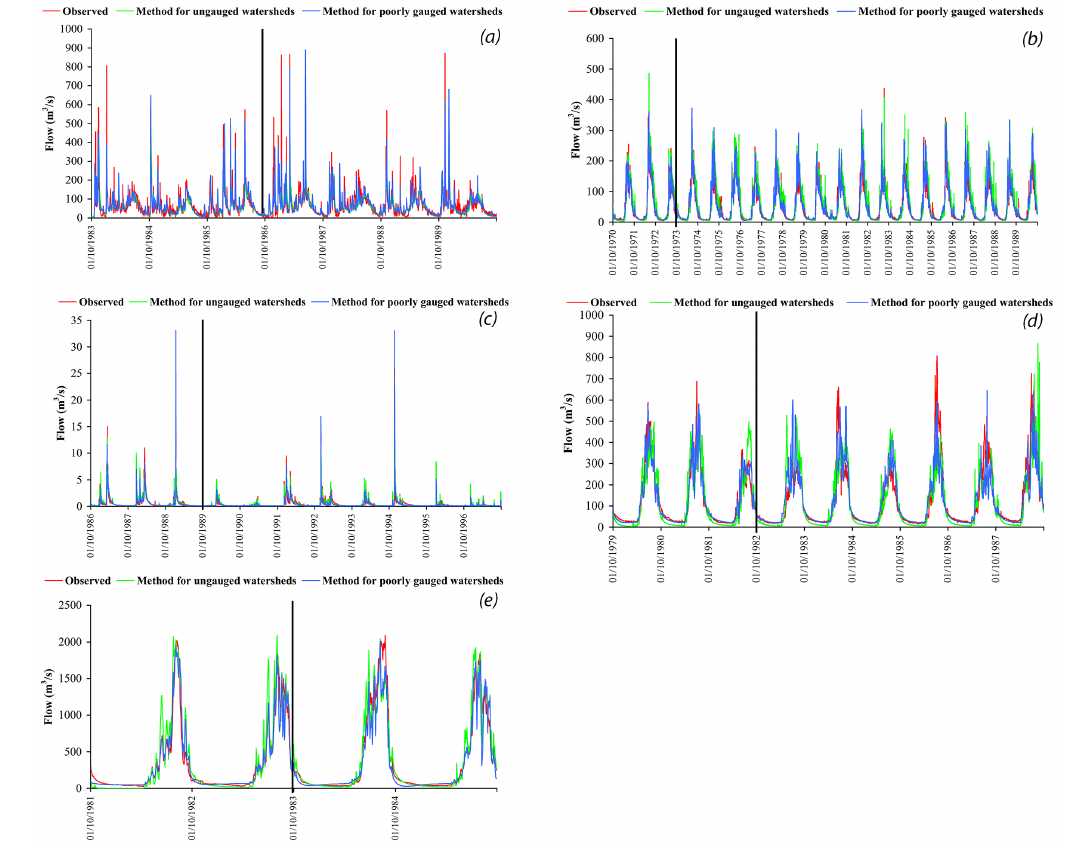
Figure 3. Comparison of observed and simulated hydrographs for the (a) Upper Campbell, (b) Illecillewaet, (c) Yermasoyia, (d) Astor, and (e) Hunza